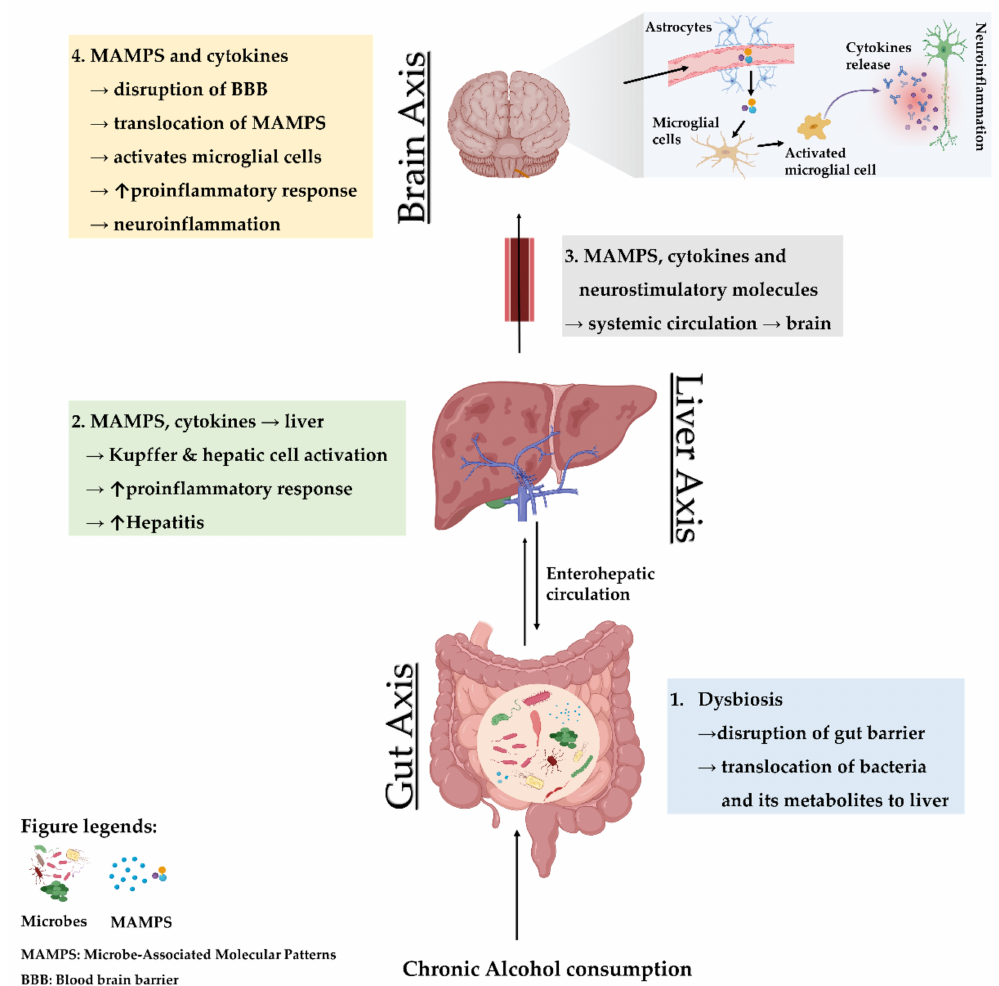
Figure 1. Gut–liver–brain axis in alcohol use disorder. Abbreviations: ↑ indicates an increase in the condition or level; MAMPS, microbe-associated molecular patterns; BBB, blood–brain